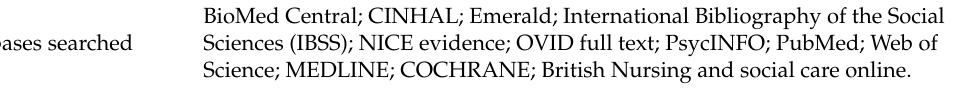
Table 1. Search strategy / databases, key words and MeSH terms